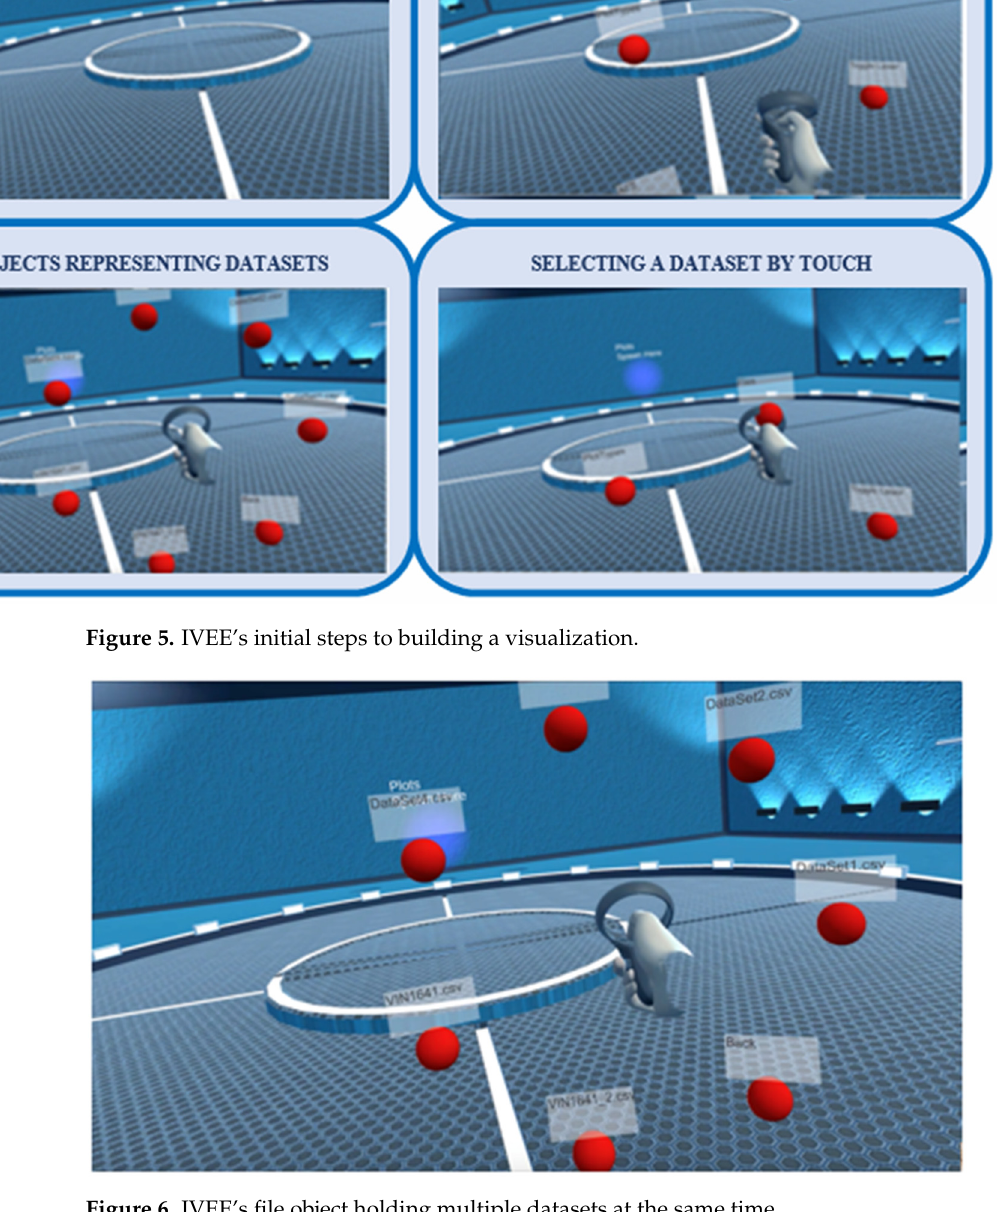
Figure 6. IVEE’s file object holding multiple datasets at the same time.